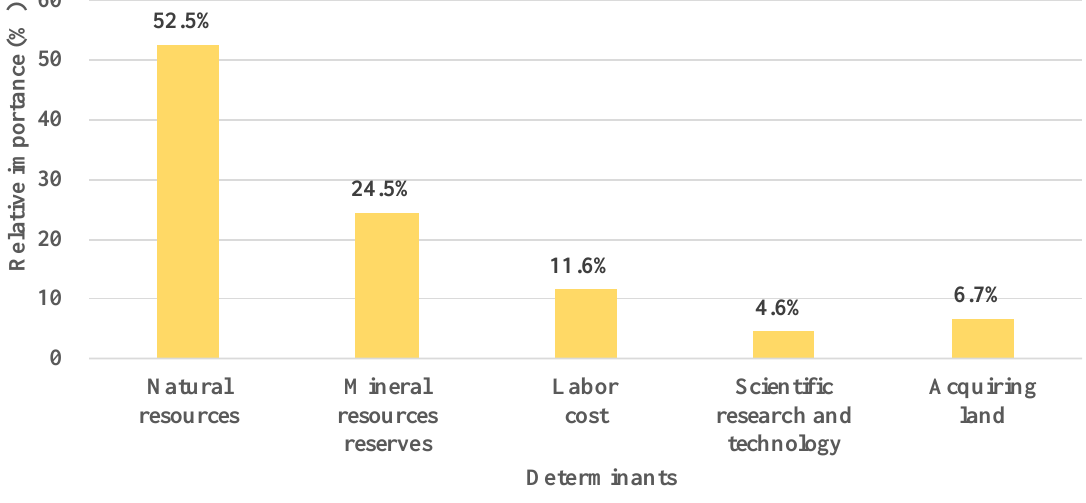
Figure 3. Relative importance of factor condition determinants.